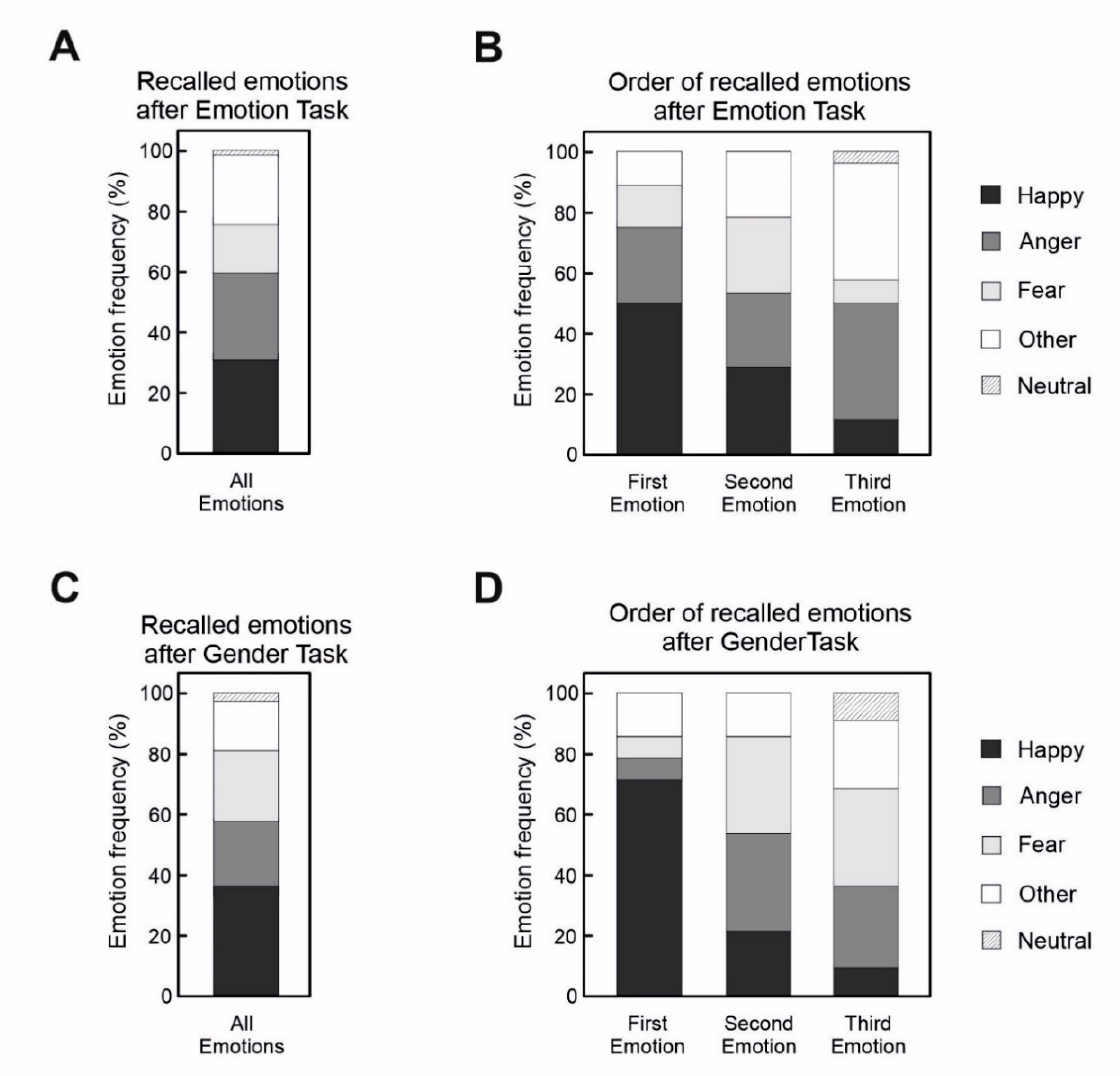
Figure 4. ( A ) Frequencies of recalled emotions after the execution of the Emotion discrimination task. ( B ) Frequencies of recalled emotions after the execution of the Emotion discrimination task according to the recall order. ( C ) Frequencies of recalled emotions after the execution of the Gender discrimination task. ( D ) Frequencies of recalled emotions after the execution of the Gender discrimination task, according to the recall order. Table 5. Results of the Chi-squared goodness-of-fit test ( χ 2 ) of recalled emotion frequencies in the first, second, and third place of recalling. Standardized residuals (SR) were used to compute p -values for the post hoc tests. Statistically significant results are reported in bold. Recalled Emotions after Emotion Recalled Emotions after Gender Discrimination Task Discrimination Task Value of Parameters